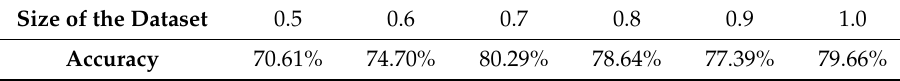
Table 5. The relationship between the size of the dataset and the accuracy.